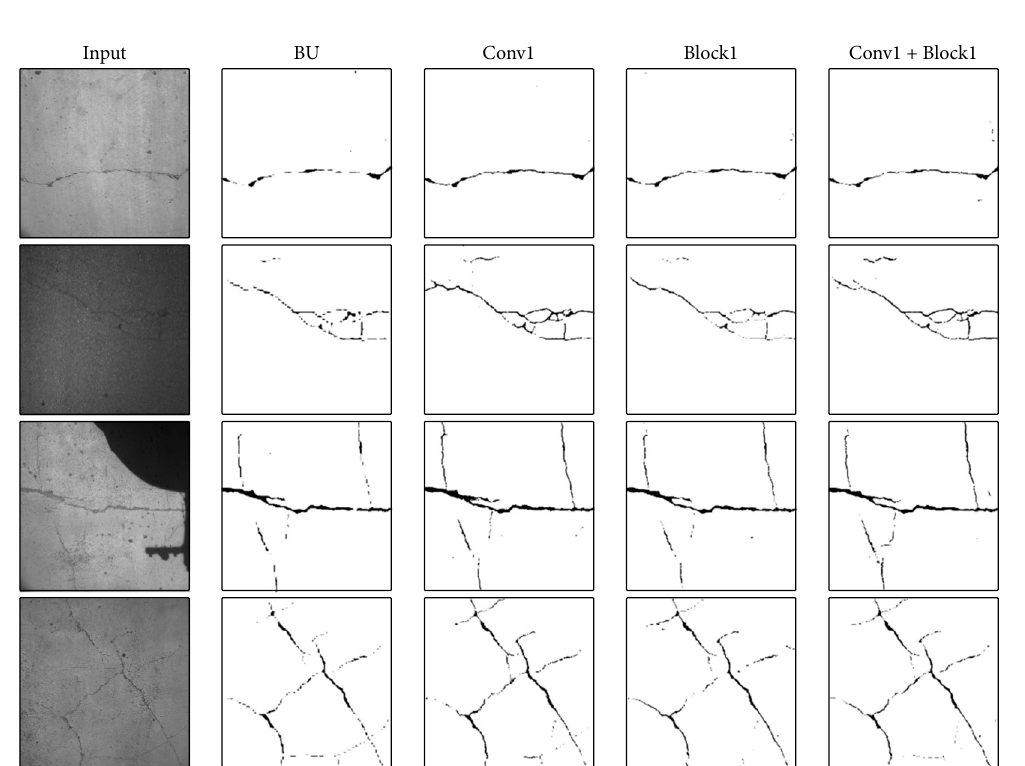
Figure 8: Comparisons of the crack detection results with different low-level features in upsampling